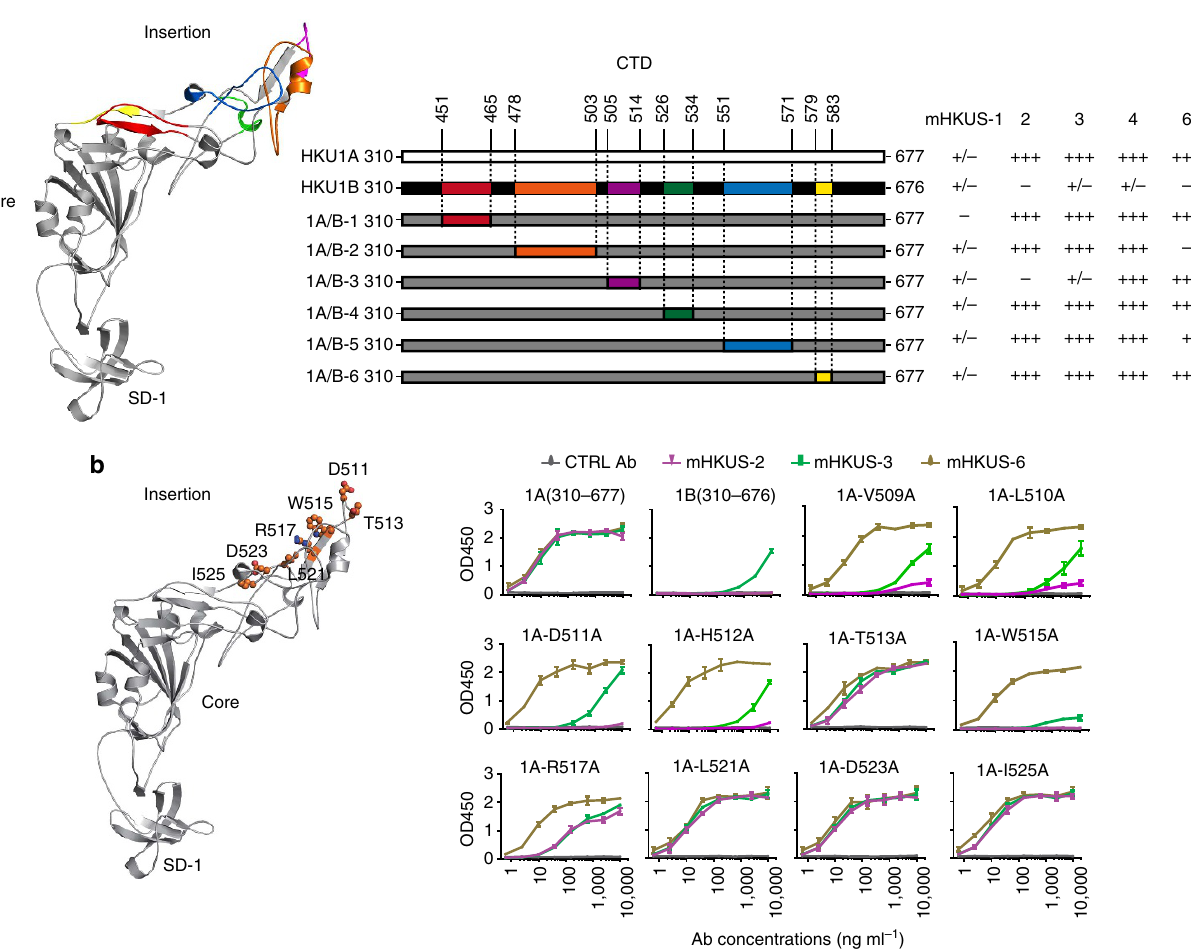
Figure 5 | Epitope mapping for neutralizing mHKUS-2 and mHKUS-3 antibodies in 1A-S310-677aa. ( a , left) Structure of 1A-S310-677aa; middle, schematic diagram of different 1A/B CTD chimeras; right, binding of different mHKUS antibodies to 1A/B chimeric proteins measured by ELISA. þ þ þ , positive signal with antibody concentration o 10ngml (cid:2) 1 þþ , positive signal with antibody concentration 10–100ngml (cid:2) 1 ; þ , positive signal with antibody concentration 100–1,000ngml (cid:2) 1 ; þ / (cid:2) , positive signal with antibody concentration 4 1,000ngml (cid:2) 1 ; -, no signal with antibody concentration at 10 m gml (cid:2) 1 . The amino acid residue numbers are from S protein of genotype A HKU1 virus. Experiments were done twice. ( b ) ELISAs were performed using purified proteins and purified antibodies. The experiments were done in triplicate and the s.d.‘s ( n ¼ 3) were shown as error bar. The experiments were performed twice and one representative is